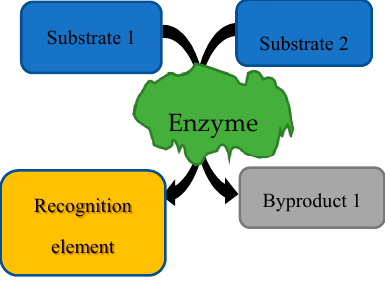
Figure 1. Generic enzymatic assay example.